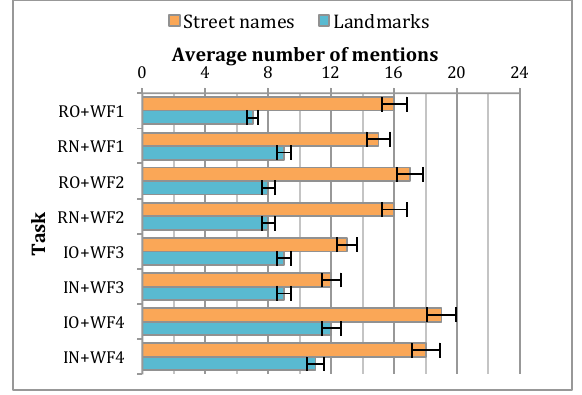
Figure 7. Street name and landmark mentions